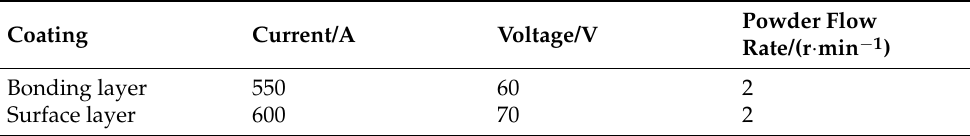
Table 1. Spraying parameters of the top coating deposited and bond coating by atmospheric plasma spraying